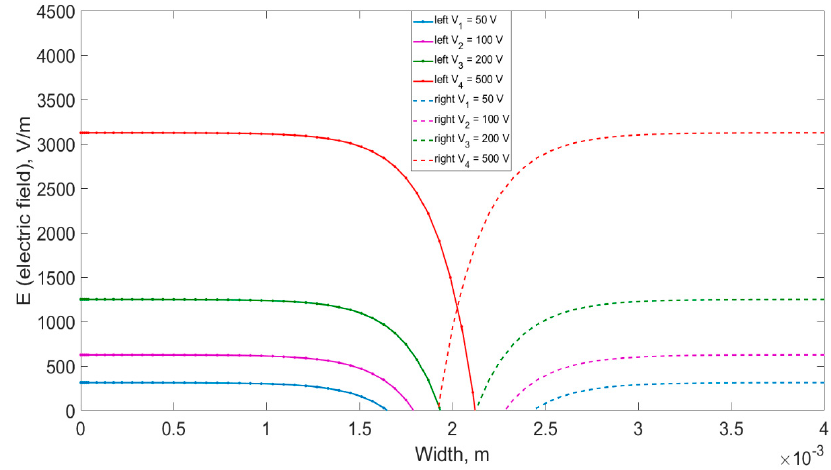
Figure 7. Electric field distribution in the cross-section of the crystal during the double-sided drift process, taking into account the presence of uncompensated lithium-ions.